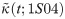
Intraday profile of the Kurtosis during 1S04.The black dots represent the values of κi(t; 1S04) and the red line κ˜(t;1S04). The ultramarine and navy blue lines represent the adjustments given by the first and second formulae in Eq (18), respectively. In this specific case the parameters are βm = 0.11 ± 0.02 and βa = 2.16 ± 0.03.